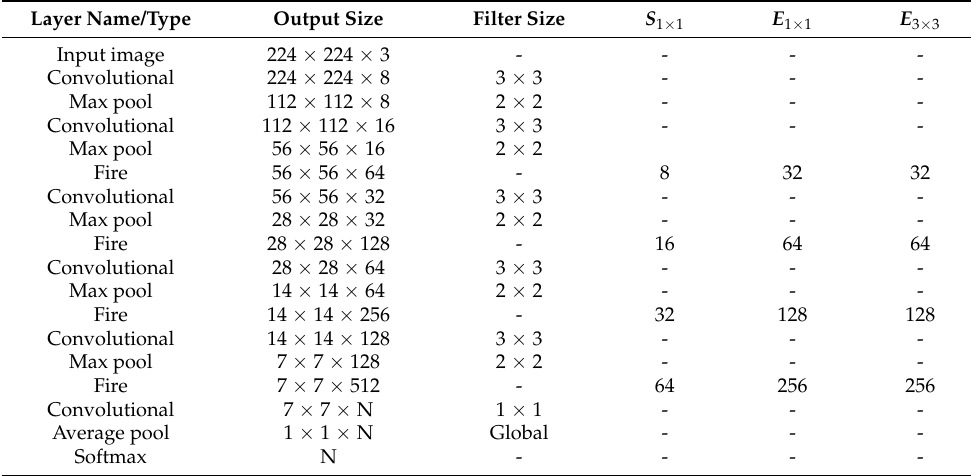
Table 1. Detailed layer configuration of FirecovNet. (N = Number of classes).